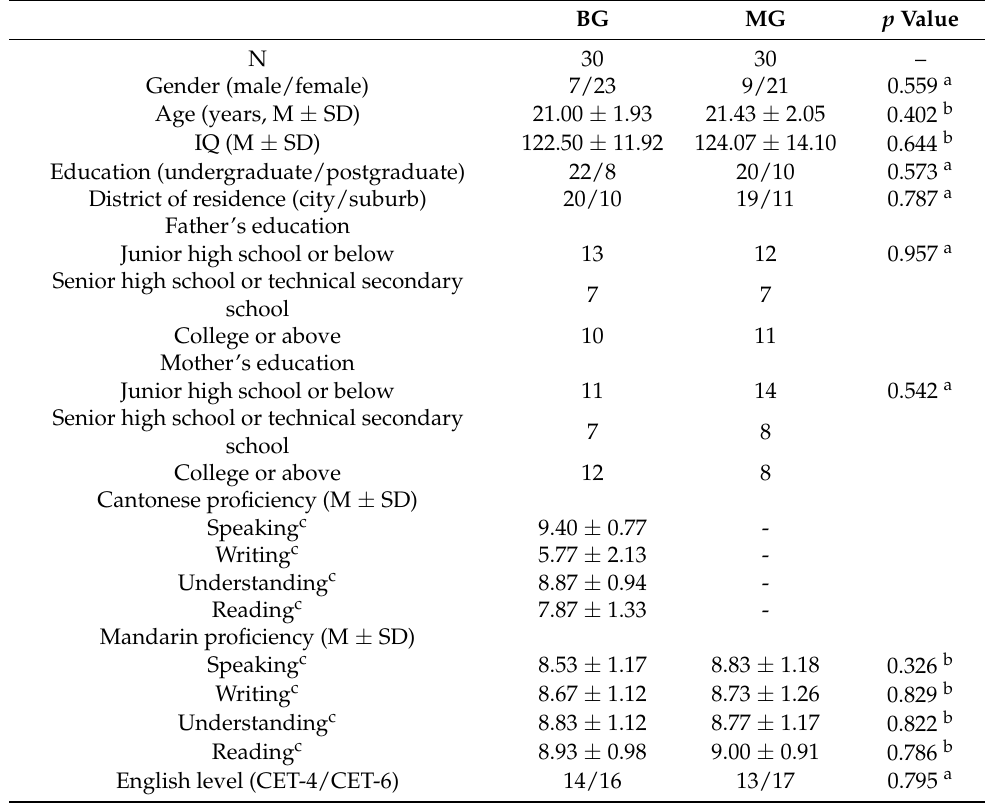
Table 1. Demographic characteristics and self-reported language assessment form the Language and Social Background Questionnaire (LBSQ) for participants in each